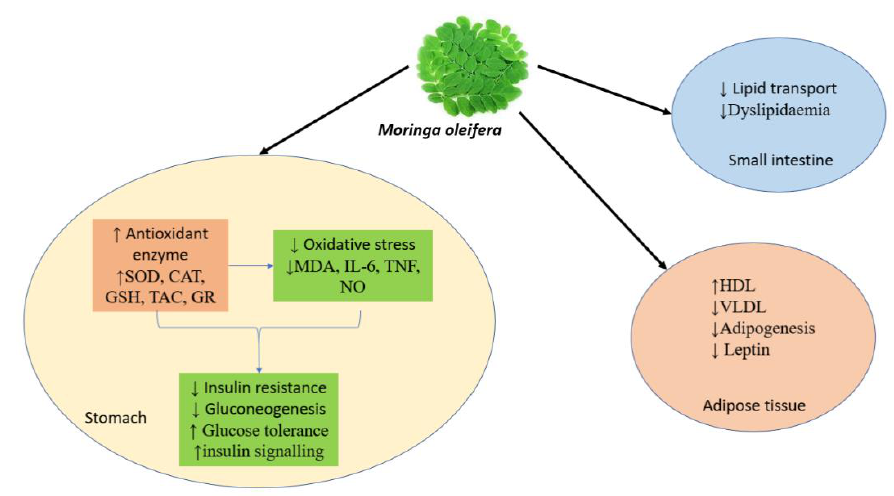
Figure 6. M. oleifera as a promising anti-obesity agent. Various in-vitro findings suggest that supple- ments of M. oleifera cause direct inhibition of pancreatic lipase, thus reducing the conversion of tri- glycerides into simple. Moringa has fat storage regulation by upregulation of lipolysis-associated protein and down-regulating the expression of protein related to fat storage. It is also effective in the improvement of antioxidant levels. Besides these, Moringa is also responsible for increasing levels and decreasing leptin, producing a feeling of ghrelin levels and decreasing leptin, producing a feeling of satiety.